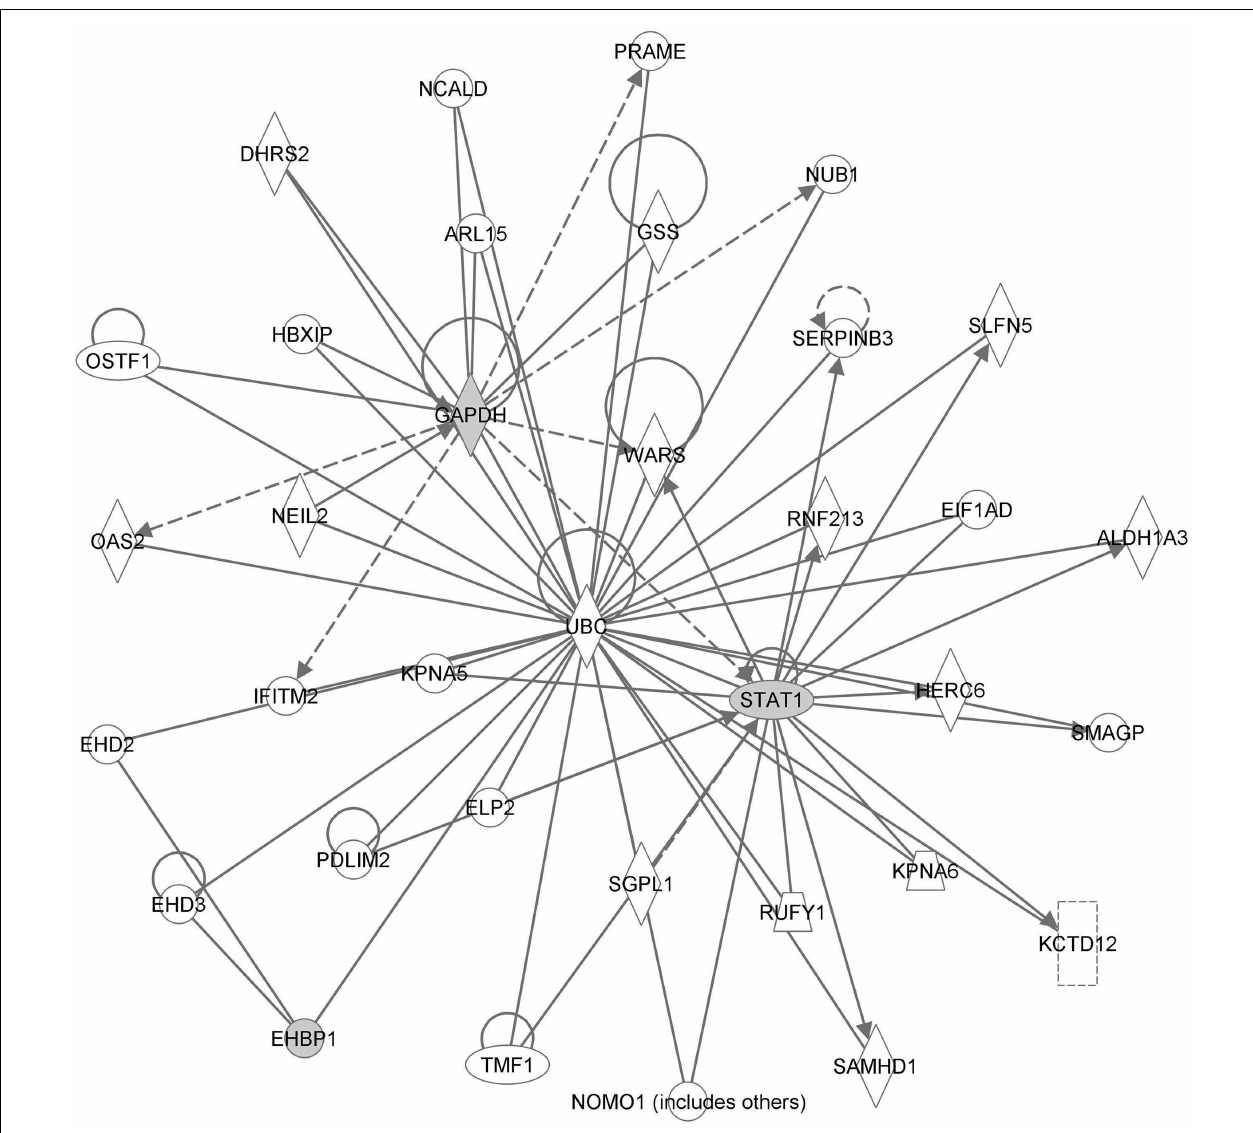
FIGURE 3 | Network analysis results . Genes present in the genetic signature are colored